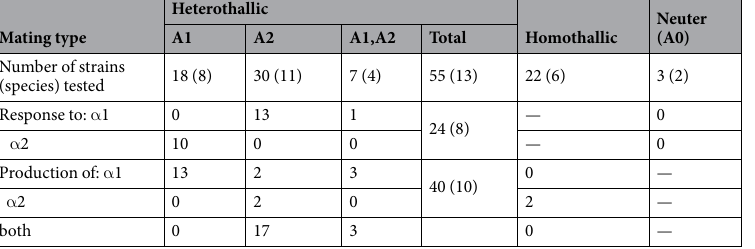
Table 2. Summary of interspecies universality of the mating hormones in Phytophthora and Halophytophthora . The number of species is indicated in parentheses. The number of species in the “total” column does not necessarily agree with the sum of each number of species within the same raw because some species contain different mating type strains. The production of the hormones at the bottom is discussed in the next section in